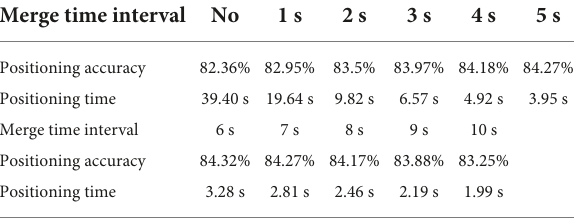
Figure 3 . The percentage of positioning accuracy in the table is the percentage of the specified positioning error within 100